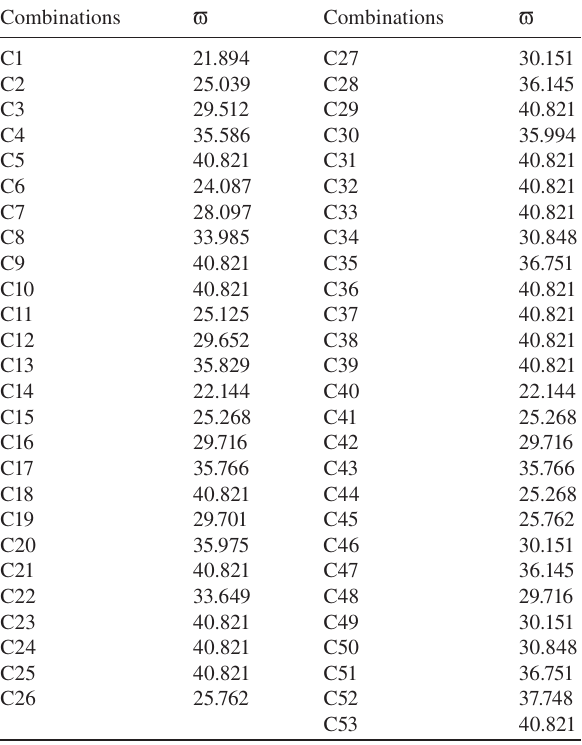
Table 4 Fundamental frequency parameter for laminated plates with two intermediate line supports for ( CCCC ) boundary